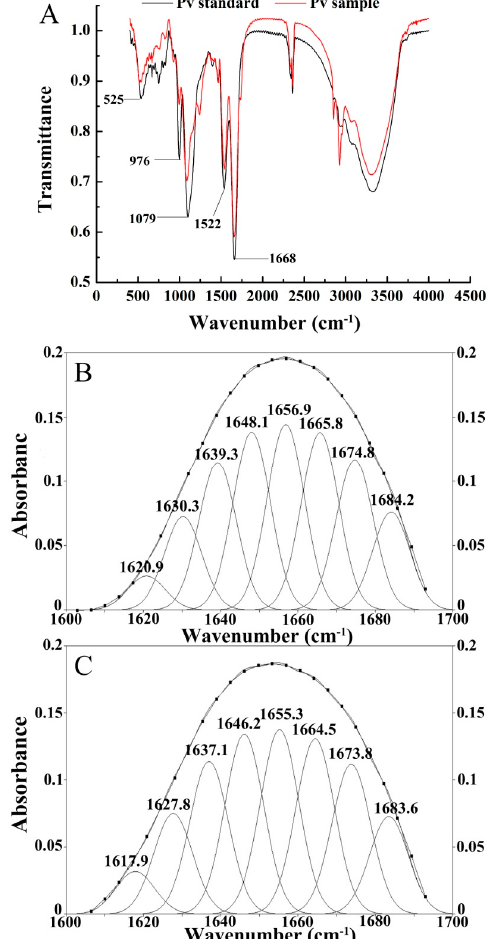
Figure 7. FT-IR of Pv. ( A ) FTIR spectra of Pv standard and purified Pv; ( B ) Fitting FTIR chart for Pv standard; ( C ) Fitting FTIR chart for purified Pv.